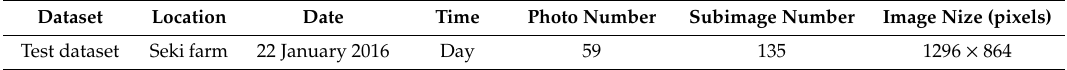
Table 3. Details of the test